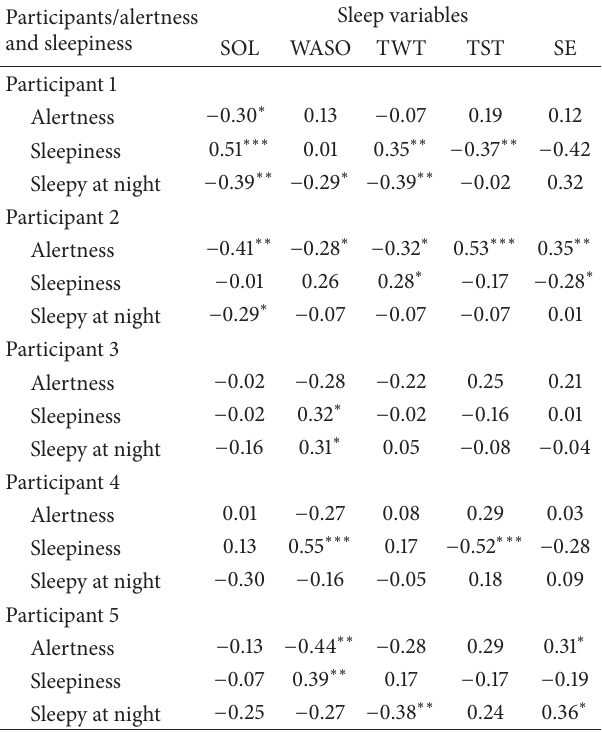
Table 6: Correlation coefficients between subjective sleepiness, alertness, and sleep variables for each participant during